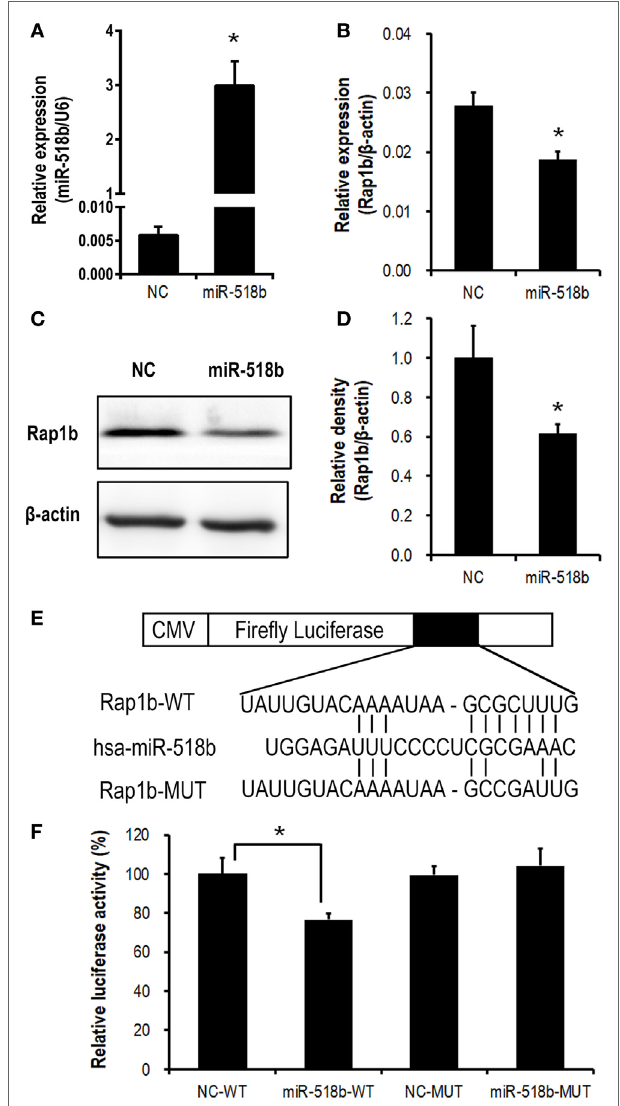
FigUre 3 | Validation of Rap1b as a direct target of miR-518b in human trophoblast cells. (a–D) Change in Rap1b expression upon miR-518b overexpression in human trophoblast cells. The HTR8/SVneo cells were transfected with miR-518b or scramble negative control (NC). The efficiency of transfection was shown in (a) , and the expression of Rap1b was revealed by real-time PCR (b) and Western blotting (c,D) . (e) Schematic diagram of the plasmid construction for dual-luciferase report assay. (F) Dual-luciferase reporter assay in HTR8/SVneo cells transfected with wild-type (WT) or mutated (MUT) reporter plasmid, and with miR-518b or scramble NC. Each of the tests was replicated for three times. Data are presented as mean ± SEM. * P <